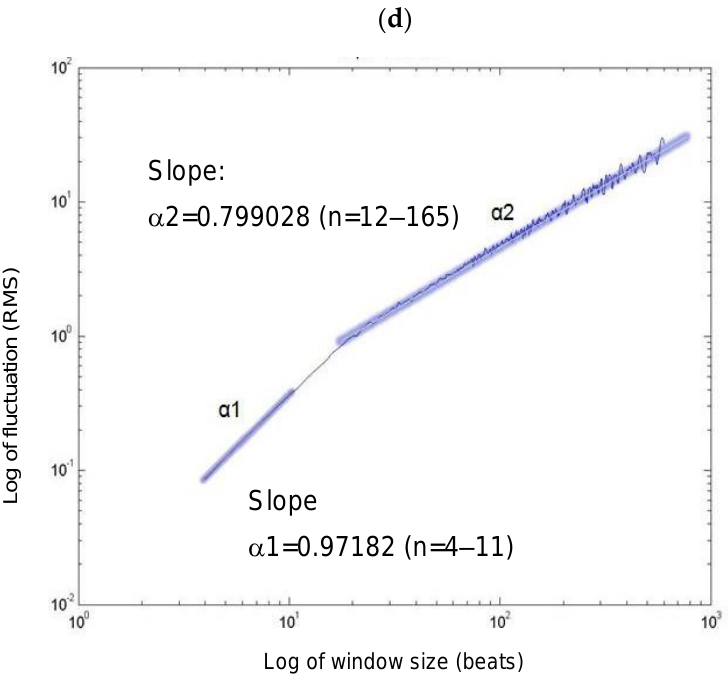
Figure 2. Calculation of DFA. ( a ) Original R–R interval and integrated time series. ( b ) The total time series was divided into segments; each segment was then detrended by subtracting the best linear fit F(n). ( c ) Root mean square of the detrended time series as a function of the segment size n. ( d ) If the time series is self-similar, a relationship indicates the presence of power law (fractal) scaling. The scaling exponent α can be estimated by a linear fit on the log-to-log plot of F(n) versus n. The α value represents the correlation properties of the time series. The global scaling exponent a value was calculated within the range of n, between n = 4 and n = 165 space. Short-term α 1 was calculated between n = 4 and n = 11.